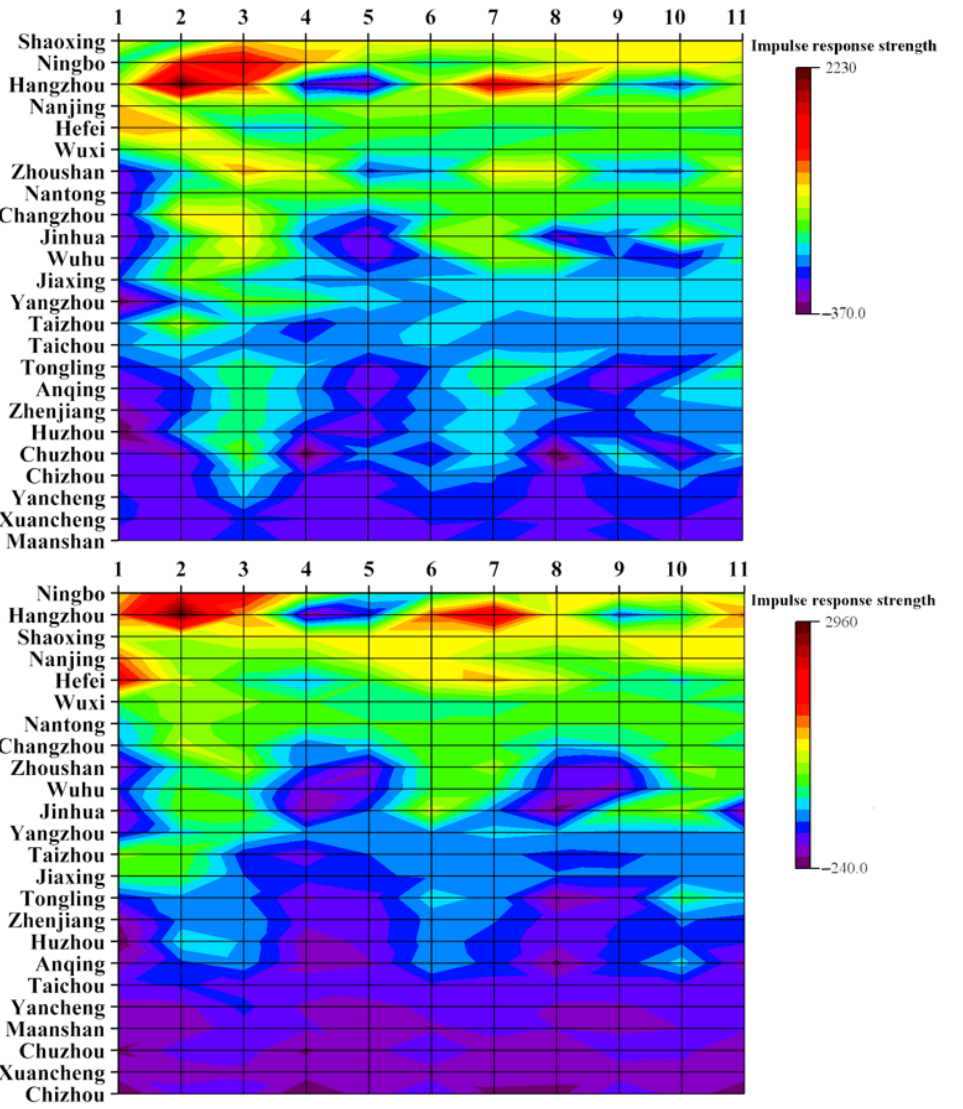
Figure 12. Impulse response results of responding cities caused by a unit impact on Shanghai ( top ) and Suzhou ( bottom ) housing prices in the YRDUA.